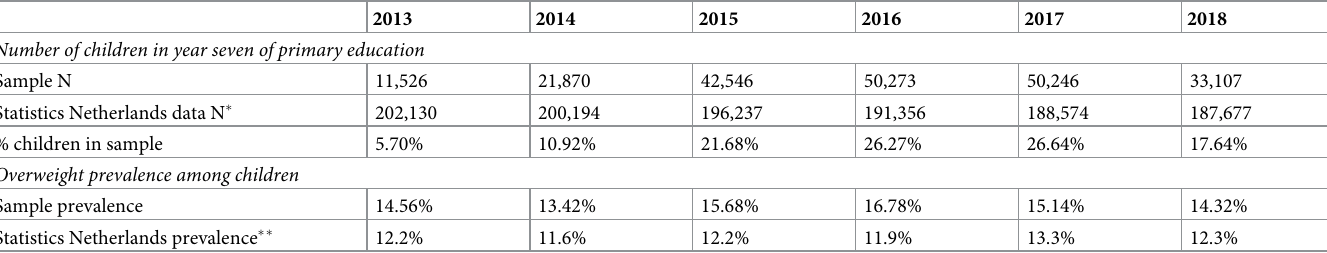
Table 1. Representativeness of the sample regarding size and overweight